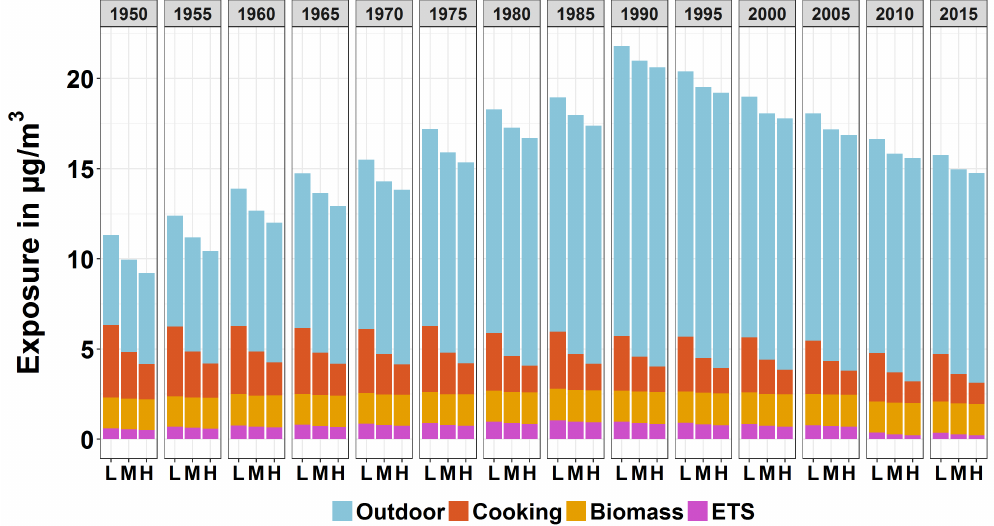
Figure 7. Population-weighted arithmetic mean NO 2 exposure by source and income level for European countries from 1950 to 2015. The “L”, “M” and “H” stand for the “Low”, “Median” and “High” level of